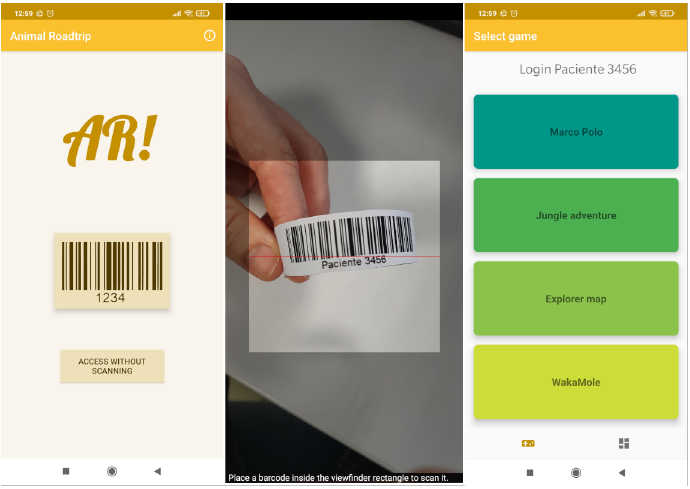
Figure 6. Overview of the login